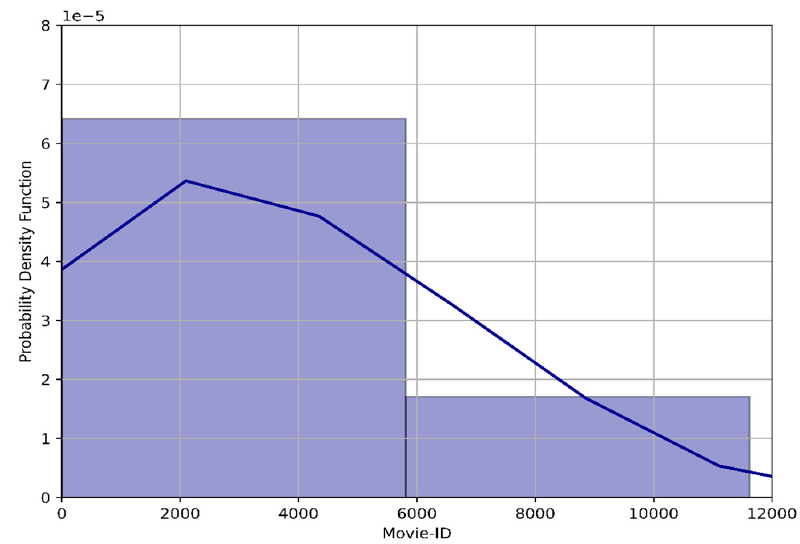
Figure 6. PDF of the selected Movie-ID.